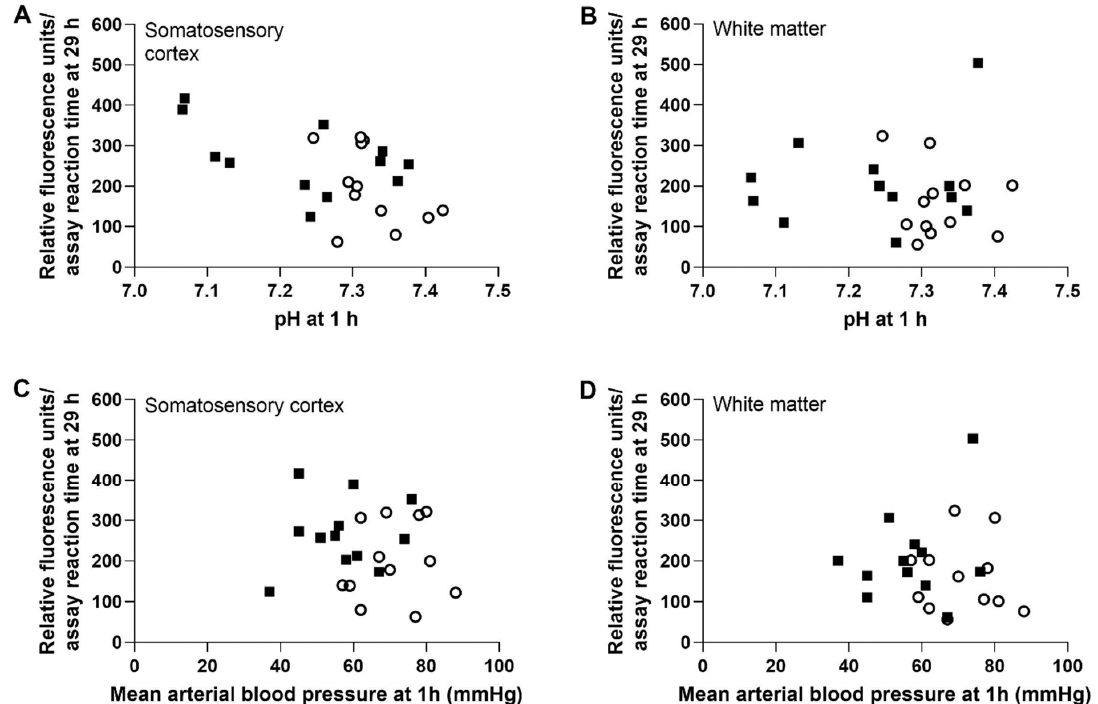
Figure 4. Correlation between the arterial pH and mean arterial blood pressure (MAP) 1 h after resuscitation and the slope of proteasome activity over the 15-min assay reaction time 29 h after resuscitation. HI piglets are represented by solid squares. Shams are represented by open circles. ( A , B ) Lower pH correlated with higher subsequent proteasome activity in the somatosensory cortex (r = − 0.538; 95% CI: − 0.773, − 0.171; p = 0.007, n = 24, A ) but not in the white matter. ( C , D ) Early MAP was not related to future proteasome activity in either brain region (n = 24). All piglets received hypothermia and rewarming.